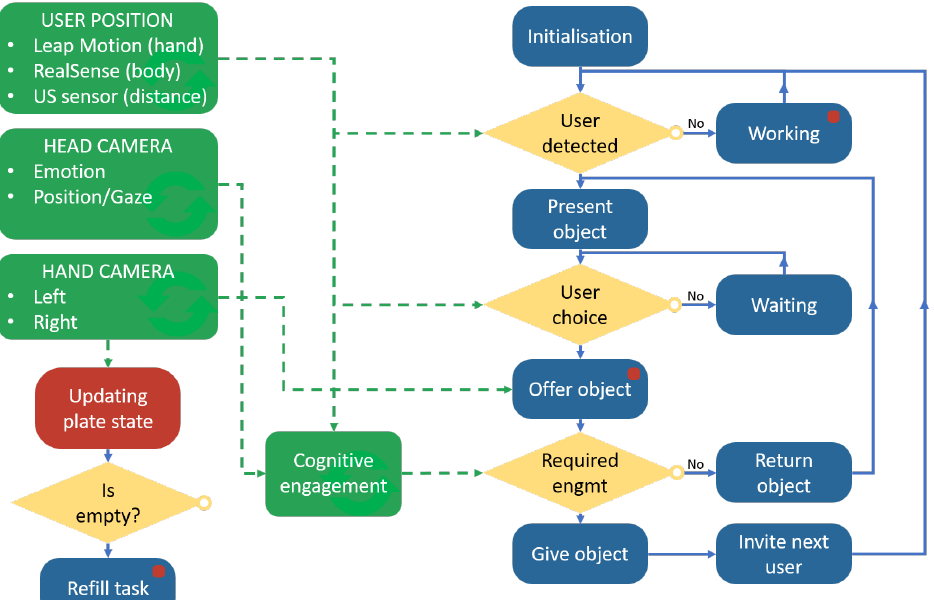
Figure 5. Flowchart of the command of the robot. The green boxes are threads running in the background and updating data. The actions with a red mark are calling the Updating plate state one. The Cognitive engagement thread estimates the engagement of the user towards the robot thanks to the user’s position, emotion or